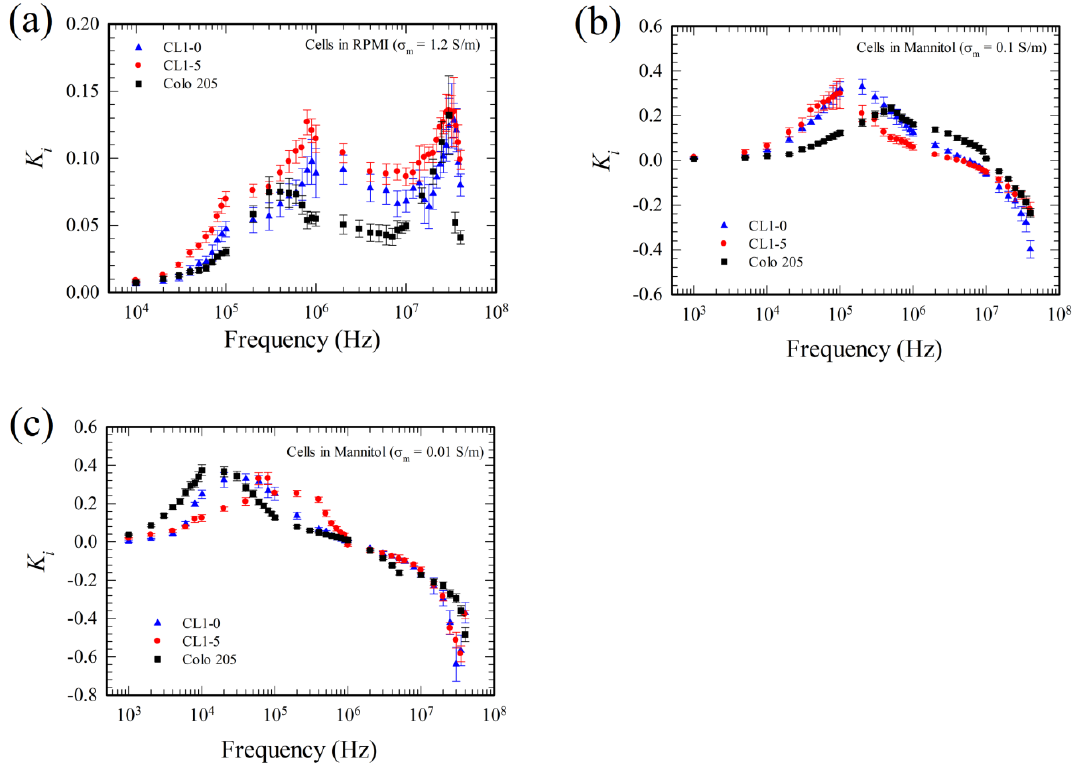
Figure 9. Comparison of K i for various cells. ( a ) Cells in RPMI solution, σ m = 1.2 S / m, ( b ) Cells in mannitol solution, σ m = 0.1 S / m, and ( c ) Cells in mannitol solution, σ m = 0.01 S / m. The results are the present measurements using the eight-electrode system operated at dual frequency.